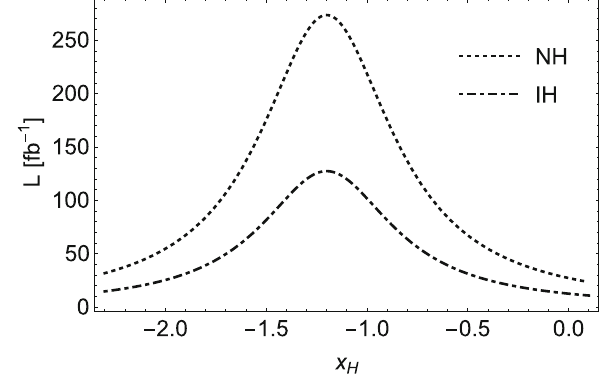
Fig. 5 In the left (right) panel, we show the parameter scan results for the maximum allowed branching ratios, μ ± μ ± W ∓ W ∓ ) , as a function of a Majorana phase ρ NH (IH) case. The solid curve denotes the maximum value of the